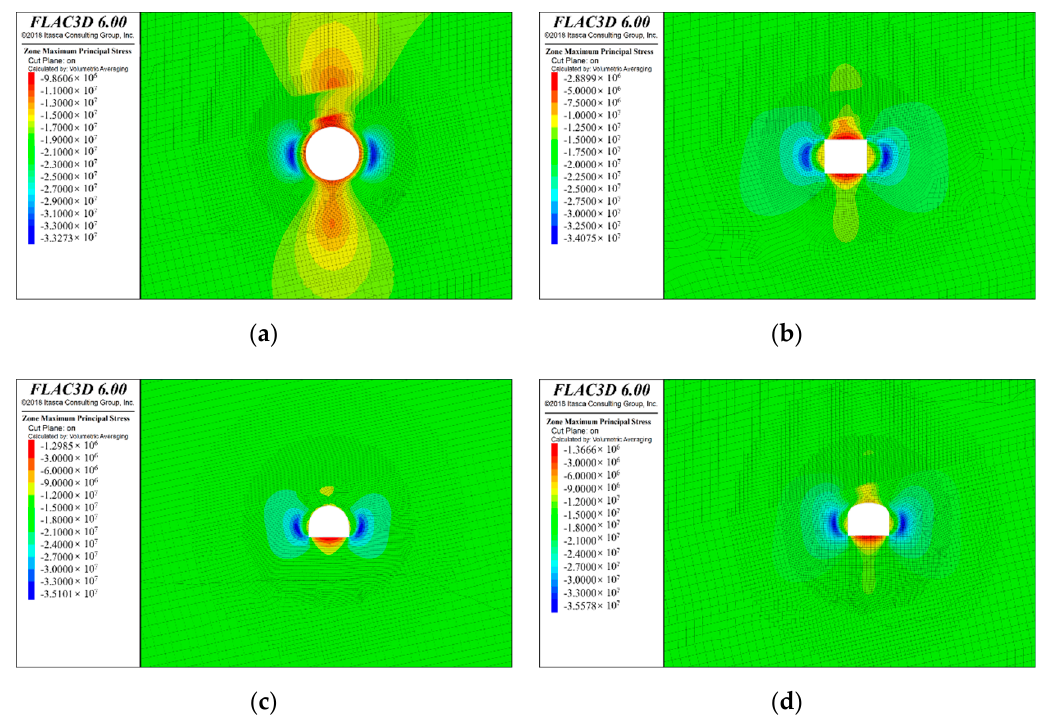
Figure 3. Influence of section shape on the cloud map of maximum principal stress distribution. ( a ) Circular section; ( b ) Rectangular section; ( c ) Semicircular arch section; ( d ) Three-center arch section.